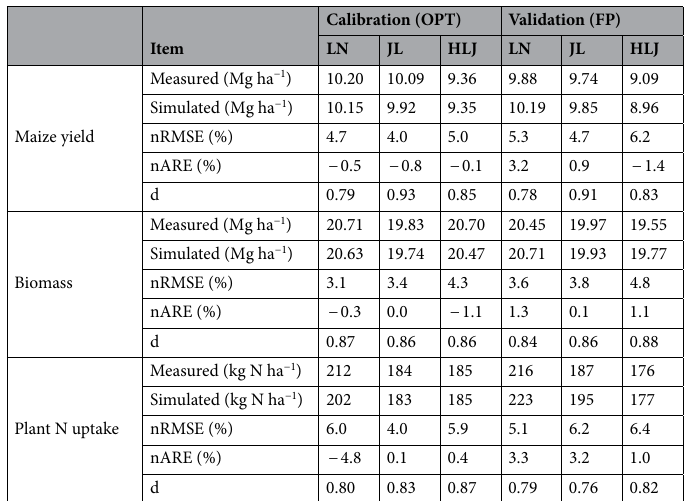
Table 1. Statistical evaluation between the simulated and measured maize yields, biomass and plant nitrogen (N) uptake from 2011 to 2016 at Liaoning (LN), Jilin (JL) and Heilongjiang (HLJ) provinces in Northeast